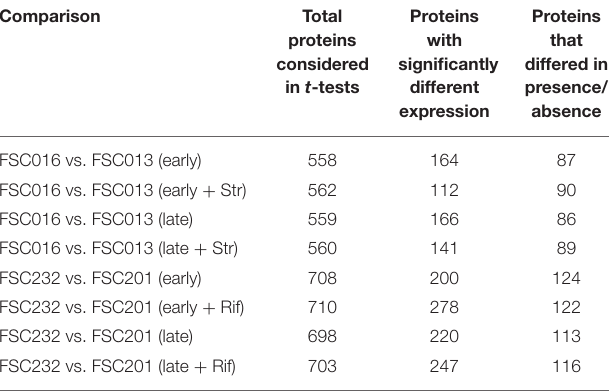
TABLE 2 | Number of proteins differentially expressed or found to differ in presence/absence between two paired sets of AMR and AMS F. tularensis strains ( p <